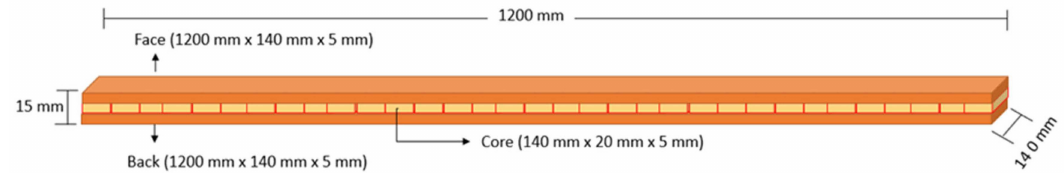
Figure 1. Scheme of cross-laminated timber (CLT) manufacturing.